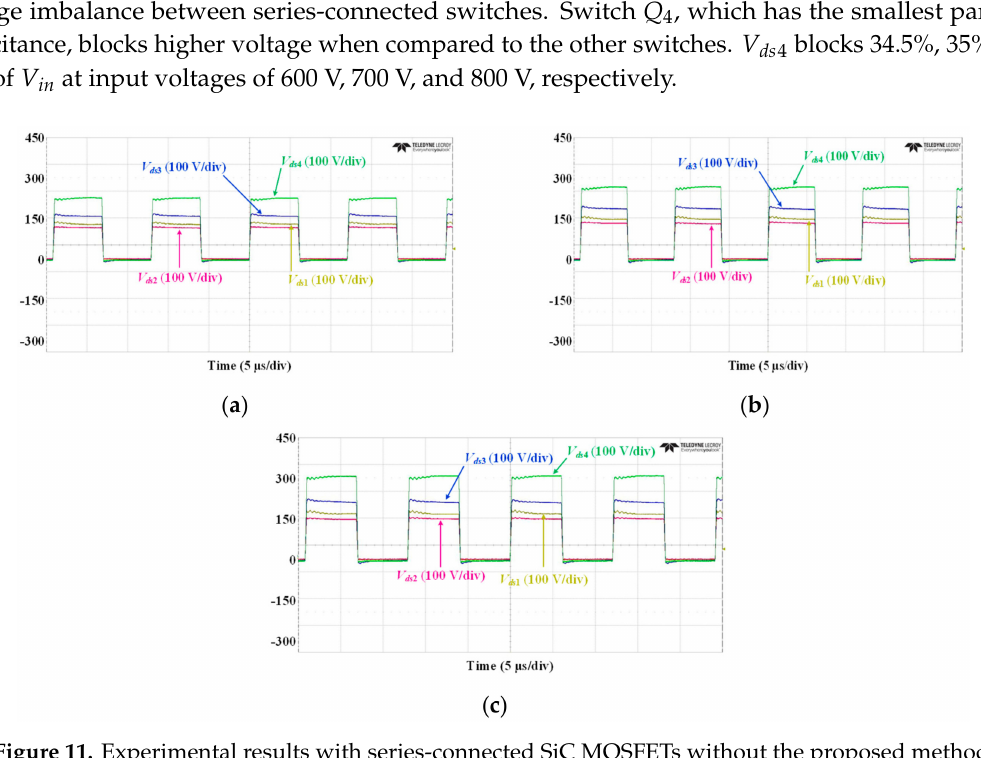
Figure 11. Experimental results with series-connected SiC MOSFETs without the proposed method: ( a ) V in = 600 V; ( b ) V in = 700 V; ( c ) V in = 800